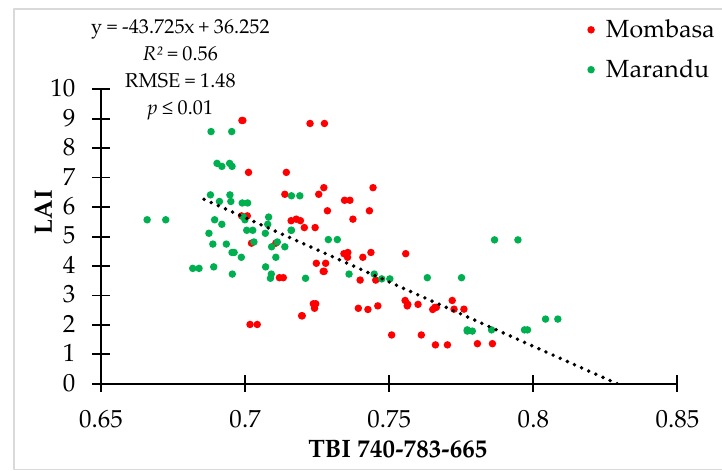
Figure 9. Graphic representation of LAI destructively measured (m 2 m −2 ) as a function of the TBI index (Three Band Index) in the Marandu and Mombasa experimental study area.